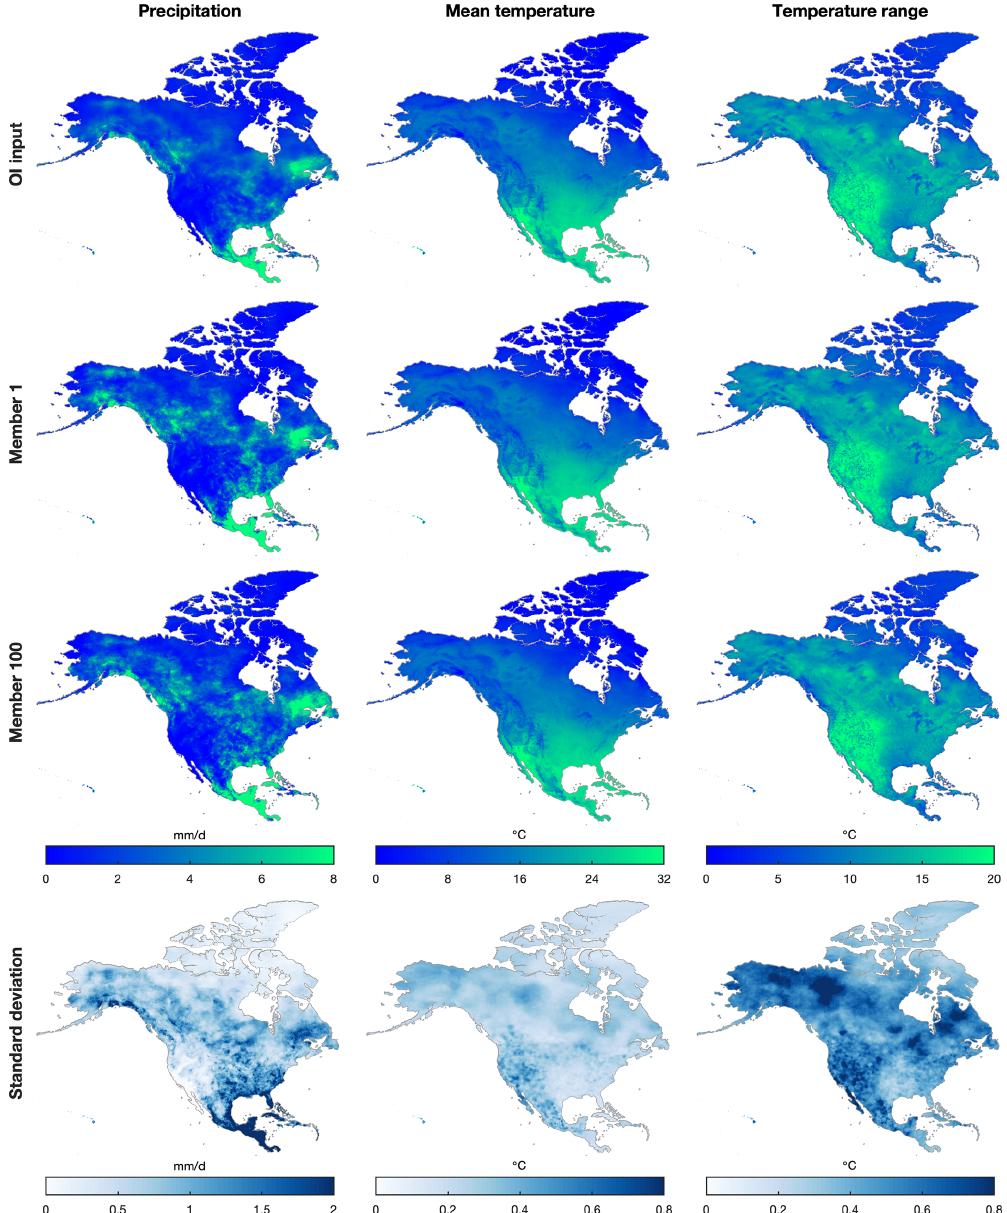
Figure 8. The distributions of average values from precipitation (the first column), mean daily temperature (the second column), and daily temperature range (the third column) averaged over the period 1–30 June 2016. The first to third rows represent estimates from OI-merged inputs, ensemble member 1, and ensemble member 100. The fourth row represents the standard deviation of all the 100 members for 1 month (June